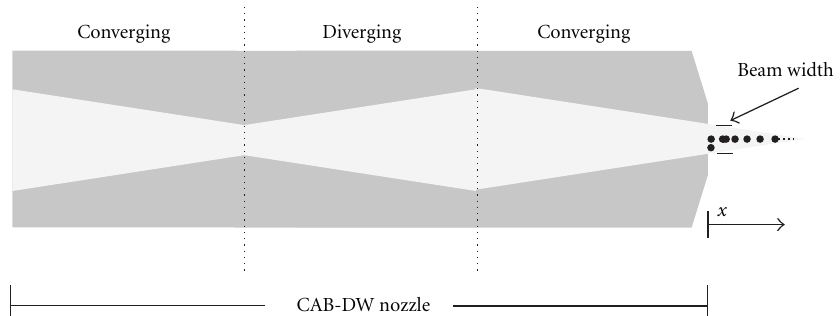
Figure 2: Illustration of 3-component converging-diverging-converging CAB-DW nozzle and measurement of aerosol beam width.